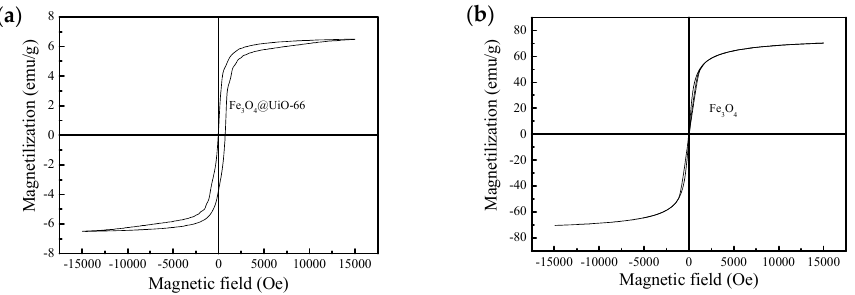
Figure 3. Magnetization hysteresis curves of ( a ) Fe 3 O 4 @UiO-66 and ( b ) Fe 3 O 4 .